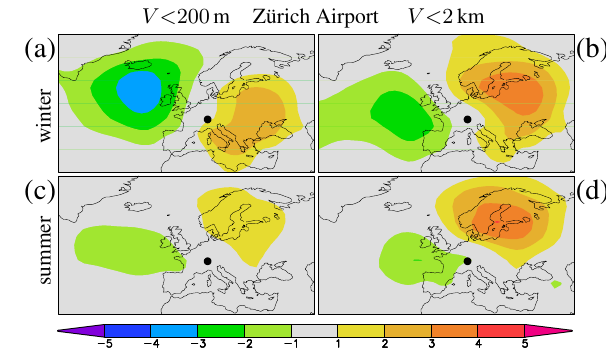
Fig. 6. Composite of daily mean sea-level pressure anomalies [hPa] at days with low visibility in De Bilt, the Netherlands (dot) in win- ter (a) and (b) October–March, and summer (c) and (d) April– September. In (a) and (c) SLP anomalies at days with dense fog (visibility less than 200m) is shown, in (b) and (d) at days with visibility less than 2km.